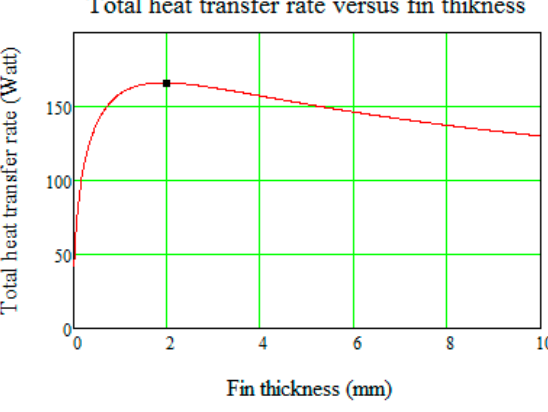
Figure 8. Total heat transfer rate versus fin thickness.